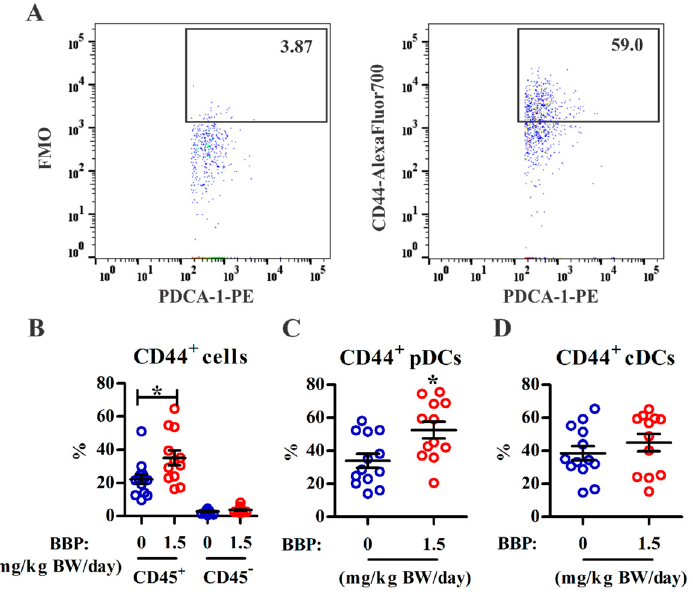
Figure 3. BBP exposure enhances CD44 expression in the pDC subset. Endometriotic lesions were pooled from each single mouse for analysis of CD44 expression among DC subsets. ( A ) Representative dot plots are shown for CD44 expression in pDCs from BBP-treated mice (1.5 mg/kg BW/day). The CD44 + cells were gated according to the fluorescence minus one (FMO) control. ( B ) Percentages of CD44 + cells among CD45 + immune and CD45 − nonimmune cells in lesions from control and 1.5 mg BBP groups. ( C , D ) Percentages of CD44 + cells among pDCs ( C ) and cDCs ( D ) from control and 1.5 mg BBP lesions ( n = 12 or 13 mice/group from four independent experiments). Each data point represents data from one mouse. The black horizontal lines and error bars represent the mean and SEM for each group, respectively. * p < 0.05 vs. control based on the Mann–Whitney U test.